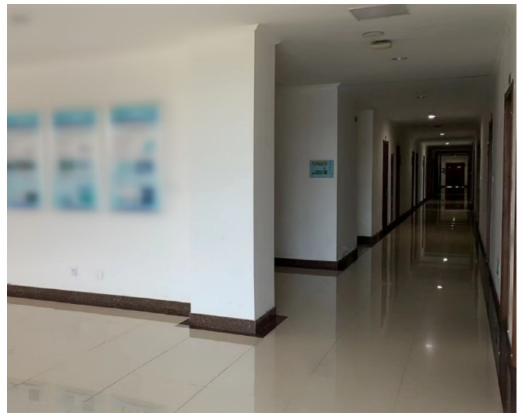
Figure 10. Indoor experimental